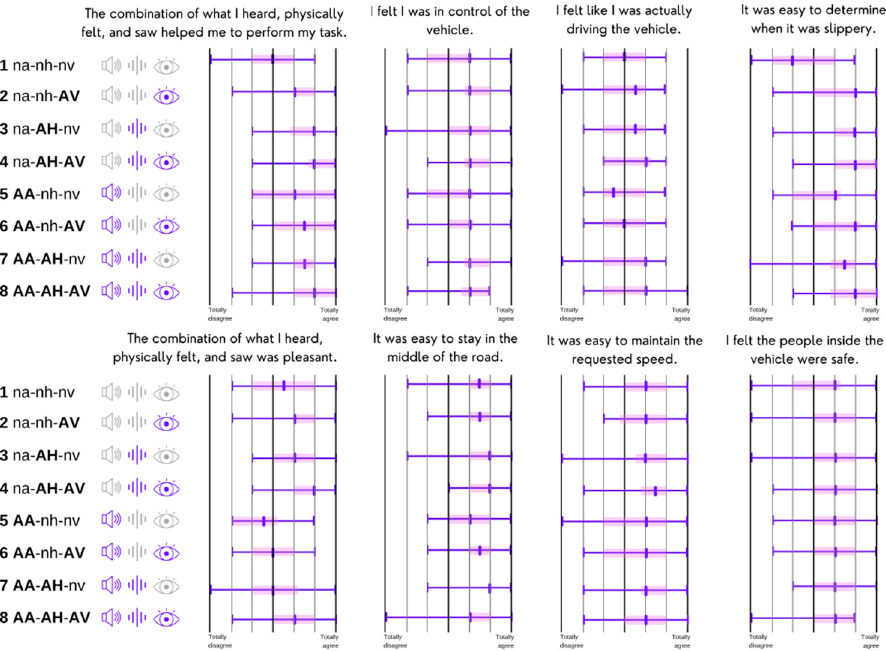
Figure 7. The distribution of participants’ responses to the condition-related questionnaire (user experience and driving-related statements).